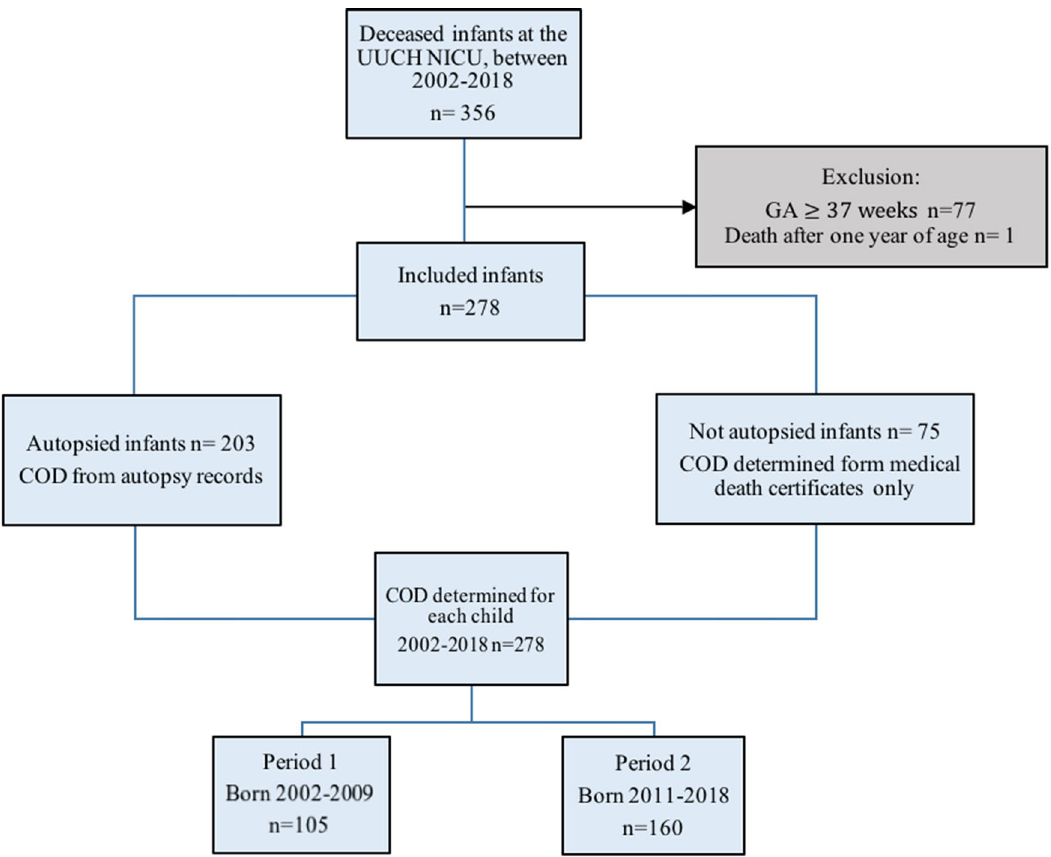
Figure 3. Inclusion of participants, data extraction and period